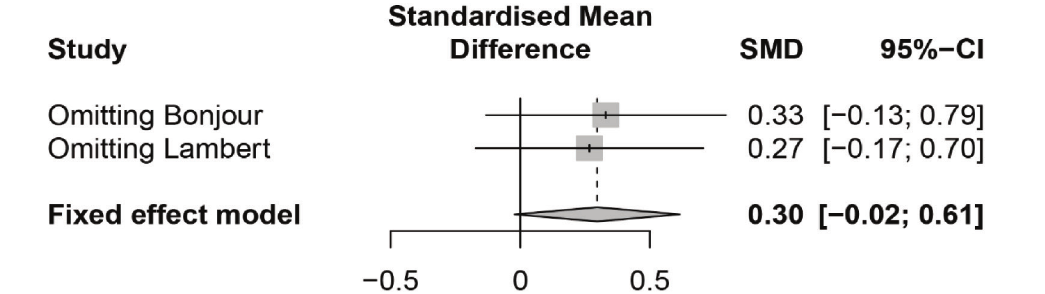
Figure 7. Meta-analysis of the effects of calcium supplement and placebo on the 2nd–4th lumbar vertebrae BMD in healthy children after exclusion of articles one by one.